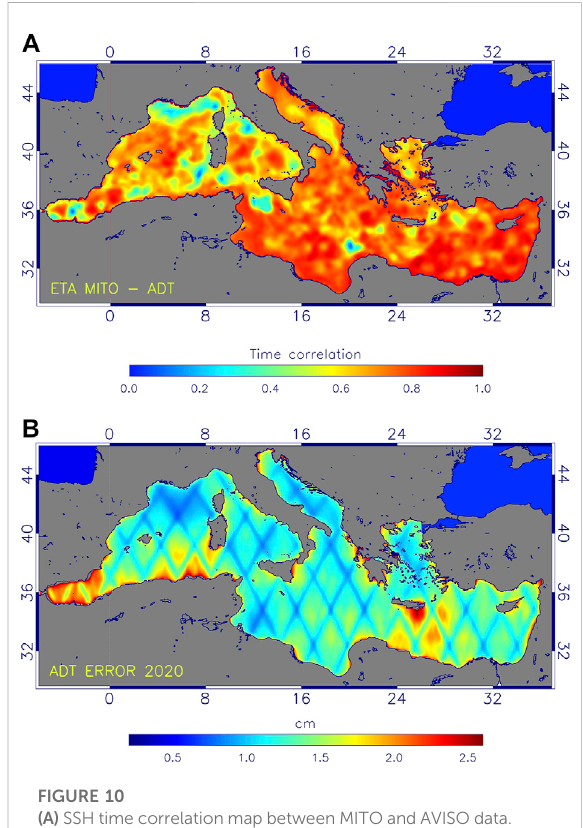
FIGURE 10 (A) SSH time correlation map between MITO and AVISO data. (B) AVISO error map for 2020 (units are in cm).